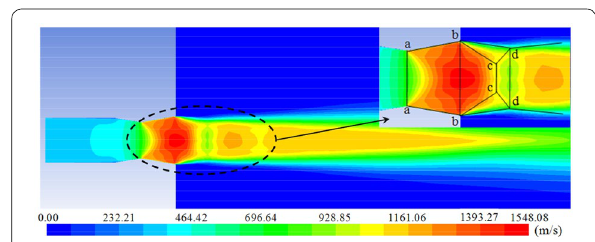
Figure 5 Mesh form of computational domain for a single engine